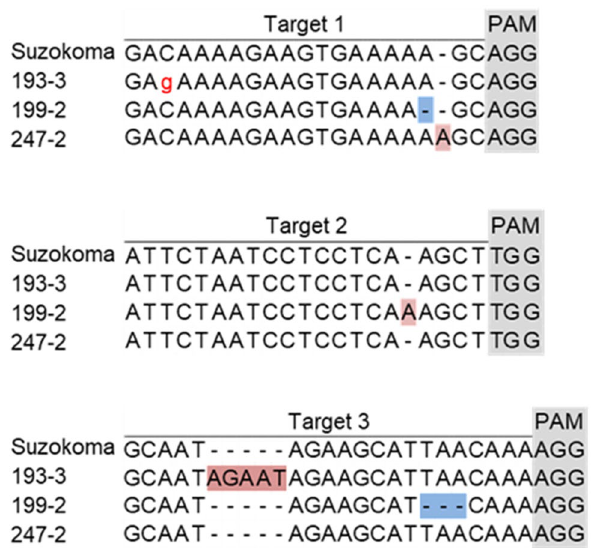
Figure 2. Mutations in SlINVINH1 of the genome edited lines. Target sequence in original cultivar ‘Suzukoma’ is shown at the top in each panel and the sequence in three genome edited lines (193–3, 199–2, and 247–2) are shown below. Grey shade indicates PAM sequence. Red shade, blue shade or red small letter show insertion, deletion, or substitution of nucleotide(s),